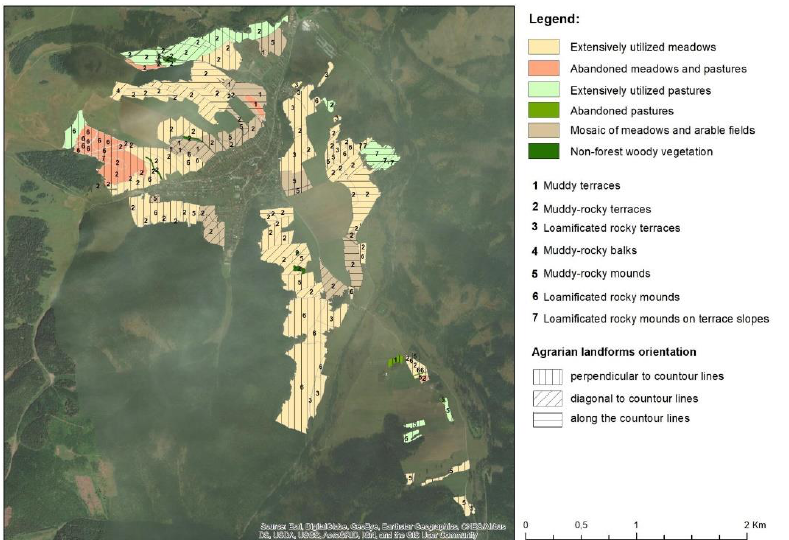
Figure 6. Types of historical structures of the agrarian landscape (HSAL), evaluation of the orientation of ramparts and terraces with respect to contour lines, and their classification into categories. Source: Base map, Esri, 2020.